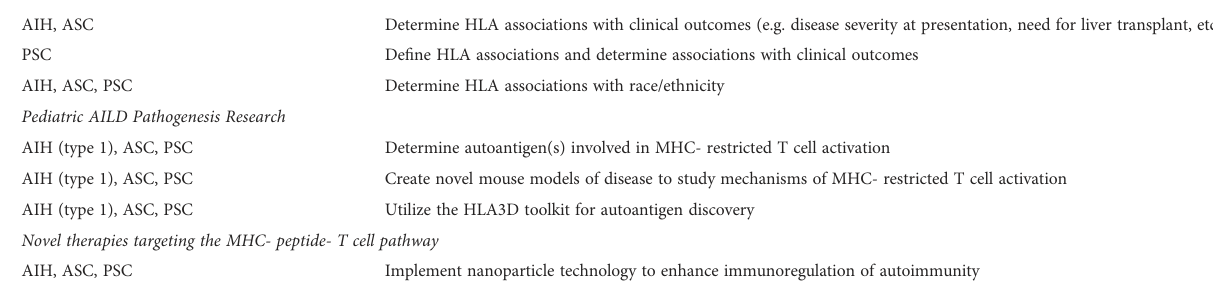
TABLE 1 Future Research Initiatives in Pediatric